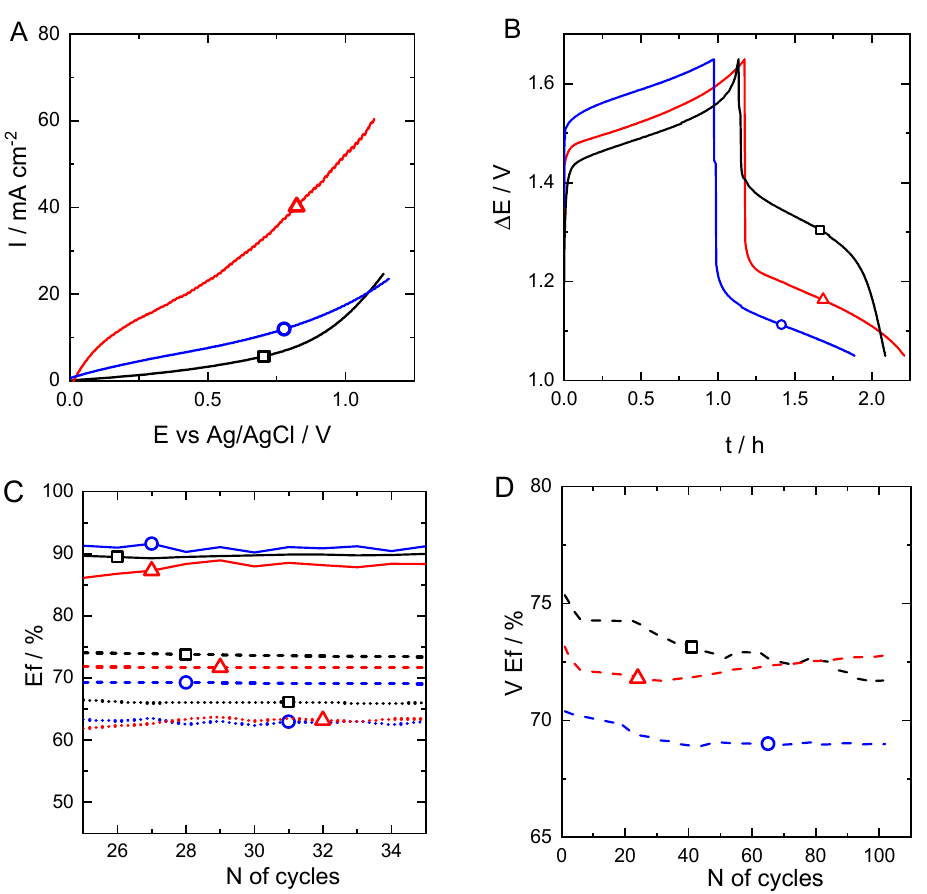
Figure 8. ( A ) Polarisation curves. ( B ) Charge–discharge curves of the same materials for one cycle at 20 mA · cm − 2 in 20 mL/half-cell of a 1.5 M V(III)/V(IV) solution prepared in 3 M H 2 SO 4 . ( C ) Coulombic (solid line), energy (dotted line) and voltage (dashed line) efficiencies along the first ten cycles at 20 mA cm − 2 after cycling at 50 and 80 mA cm − 2 , and ( D ) voltage efficiencies for one hundred cycles for samples SucNaCl0.80 ( □ ), SucNaCl1.00 ( ○ ) and SucNaCl1.25 ( △ ).